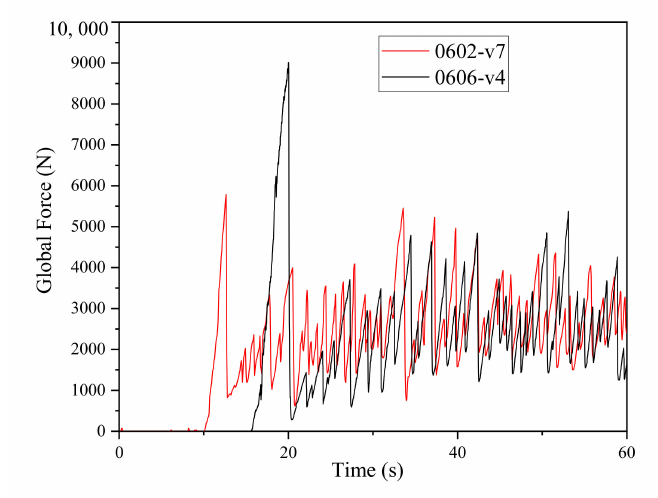
Figure 4. Total forces when V load equals 4 mm/s and 7